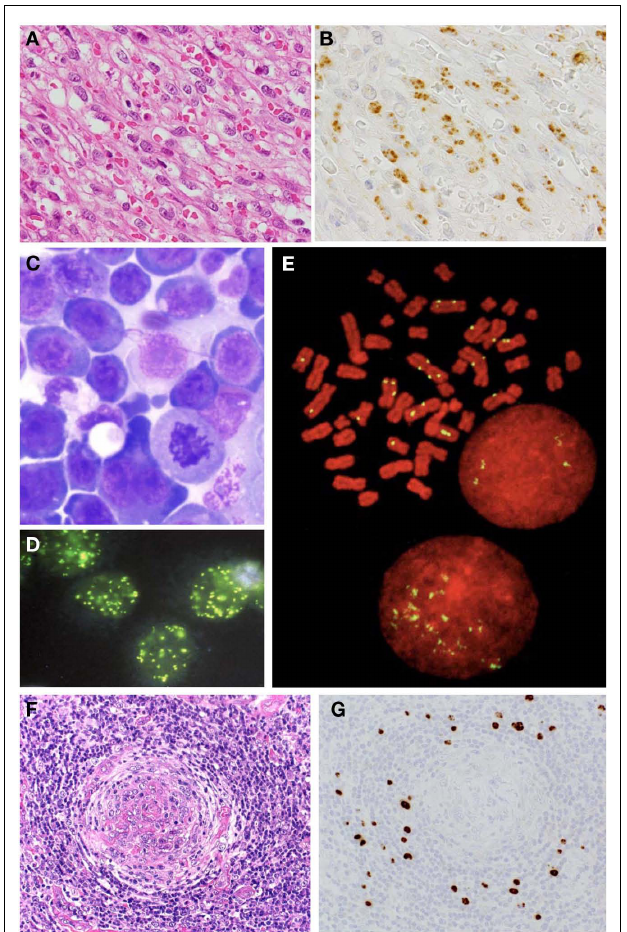
FIGURE 1 | Histological analysis on KSHV-associated diseases. (A) Nodular stage of KS; HE staining. (B) LANA-1 immunohistochemistry of KS. (C) Giemsa staining of PEL. (D) LANA-1 immunofluorescence staining in mitosis of PEL cells. (E) LANA-1 immunostaining of mitosis of PEL cell line, TY-1.Yellow signals indicate LANA-1. Red is counter staining of chromosome. (F) HE staining of MCD. (G) LANA-1 immunohistochemistry of MCD.